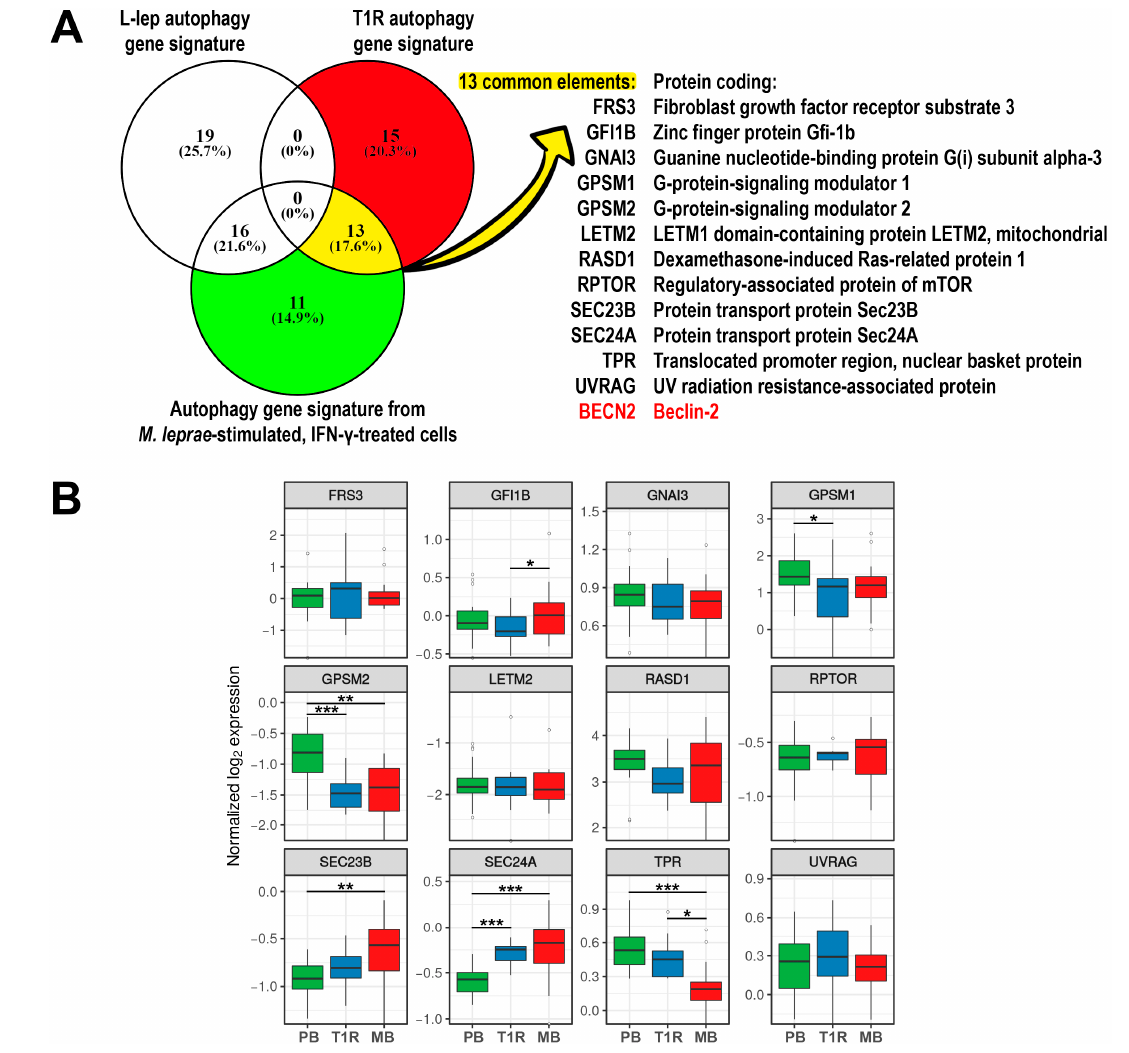
Figure 6. T1R skin lesions and THP-1 macrophages stimulated with M. leprae and IFN- γ were found to share a common autophagy gene signature. ( A ) Venn diagram overlap of autophagy gene expression signatures of leprosy skin lesions and THP-1 macrophages stimulated with M. leprae and treated IFN- γ . ( B ) Tukey box plots displaying normalized log 2 gene expression values from microarray data [34] for the 13 genes found in ( A ). BECN2 was excluded because of microarray annotation issues. Boxes represent first, second (median), and third quartiles with whiskers extending ± 1.5× the interquartile range (IQR). Means were compared using a linear mixed-effects model, allowing for heterogeneous variance among groups, followed by the Tukey multiple comparison procedure. Asterisks summarize Tukey p -values as * p < 0.05, ** p < 0.01, and *** p < 0.001. Tukey confidence intervals are described within results.